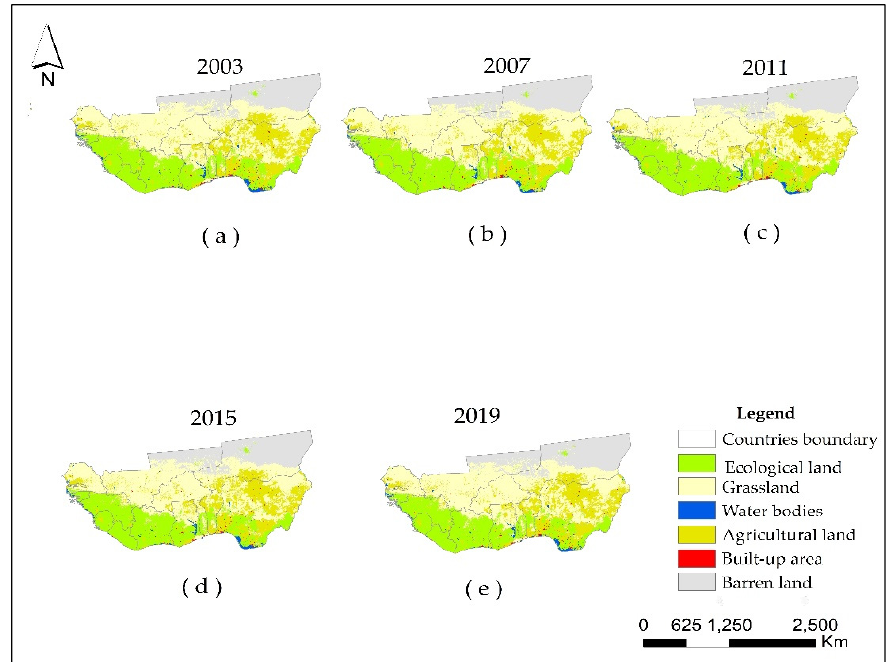
Figure 2. The situation of main land use categories in 2003 ( a ), 2007 ( b ), 2011 ( c ), 2015 ( d ), and 2019 ( e ). Table 4. The statistics of the land use types in the years 2003, 2007, 2011, 2015, and 2019 (km 2 ). Land Use